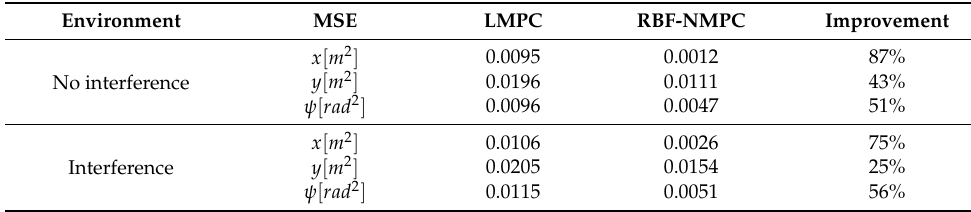
Table 2. The mean square error (MSE) of the RBF-NMPC and LMPC in trajectory tracking.